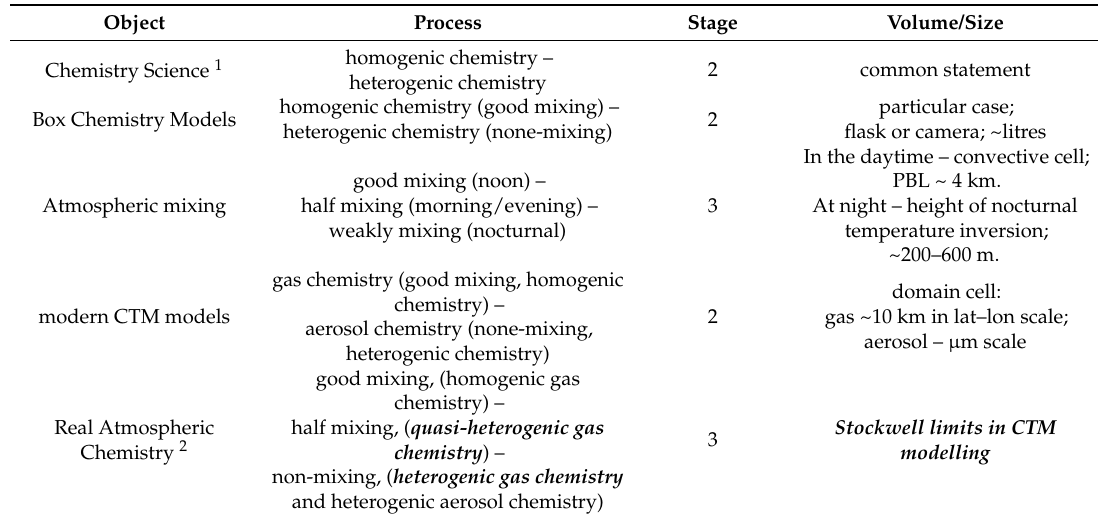
Table 3. The comparison of the processes considered in the Chemistry Science, Box Chemistry Models (BCM), Chemical Transport Model (CTM) and Real Atmospheric